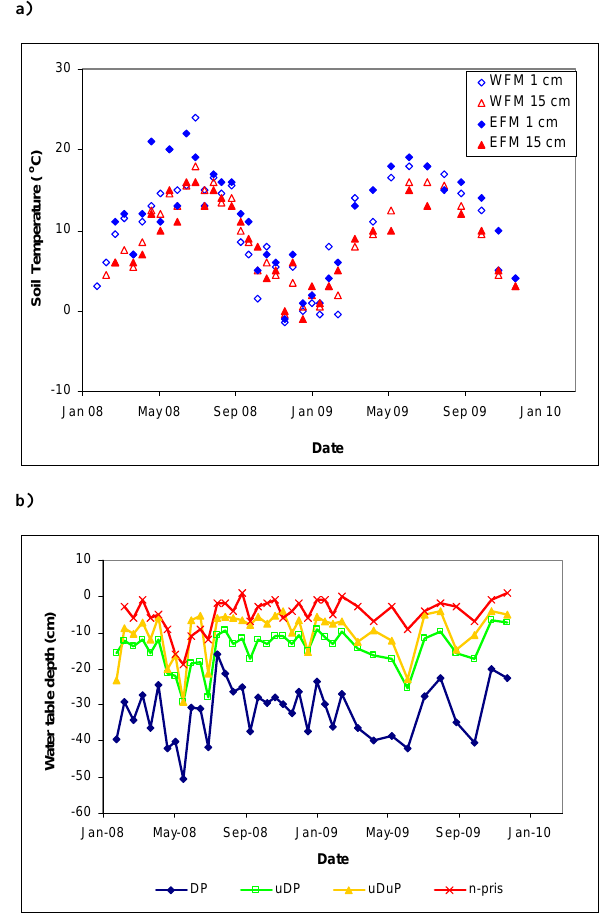
Fig. 2. Environmental variables measured at Flanders Moss during each sampling day: (a) soil temperature measured from WFM and day: a) soil temperature measured from WFM and EFM (n-pris) sites; b) Water table EFM (n-pris) sites; (b) water table depth from each treatment. depth from each treatment.